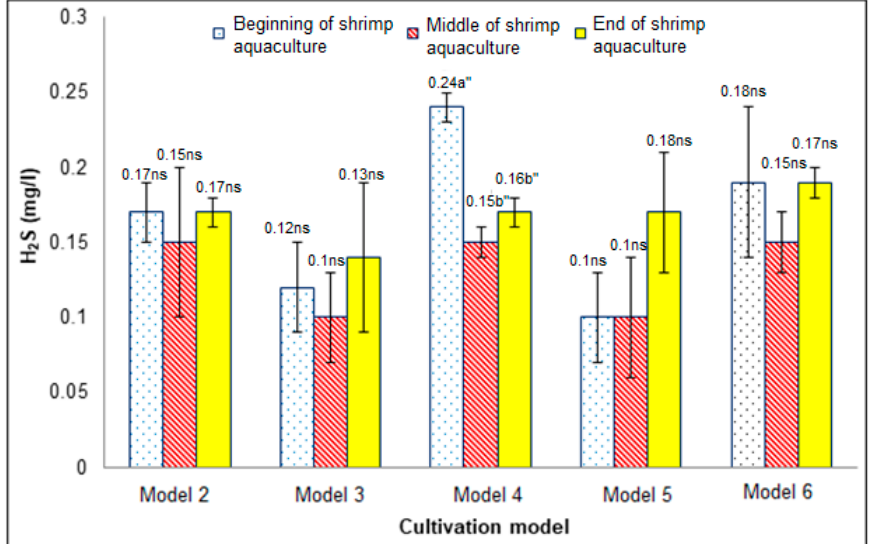
Figure 7. Fluctuations in H 2 S concentration in farming models.Notes: a and b are compared according to sampling time, the same letters within the same column or row have no significant difference. The symbol ’ is used to distinguish different experimental or model areas. ns: no difference (compared at a significance level of 5%).